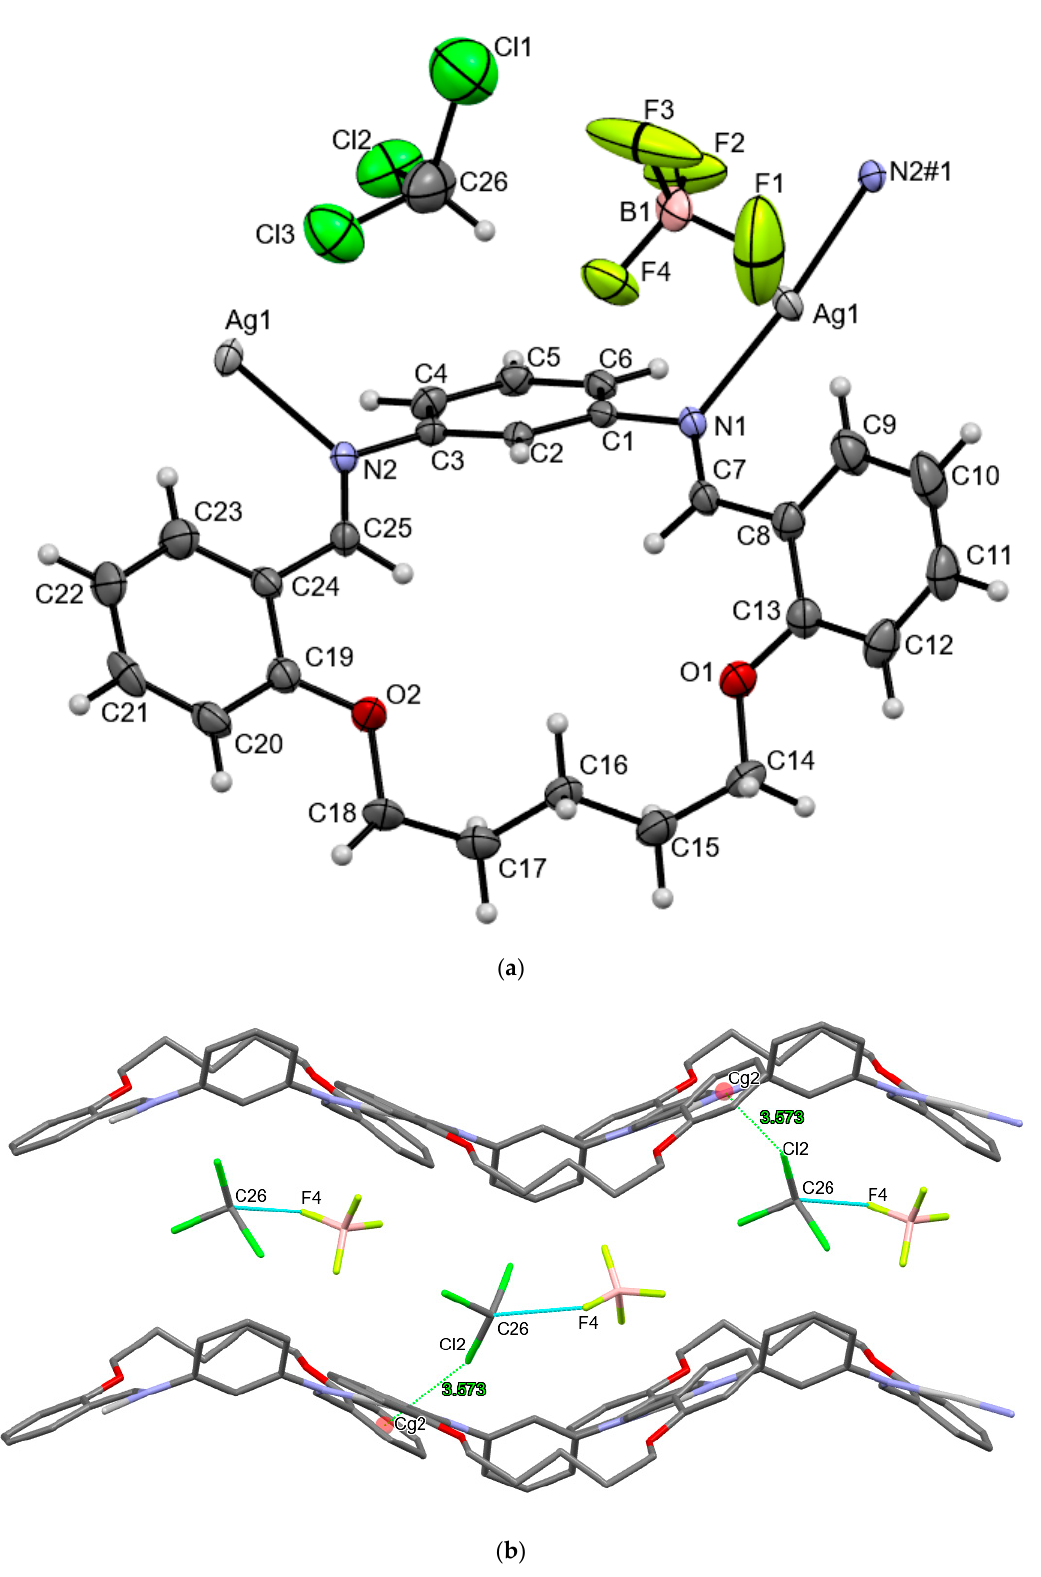
Figure 2. ( a ) ORTEP plot of AgLBF 4 with displacement ellipsoids of non-hydrogen atoms drawn at the 50% probability level. Symmetry operation: #1 1 − x , 1/2 + y , 3/2 − z . ( b ) Representation of C–H ··· F intermolecular interactions (light blue lines) and Cl ··· π interactions (green dashed lines) in AgLBF 4 . Hydrogen atoms are omitted for